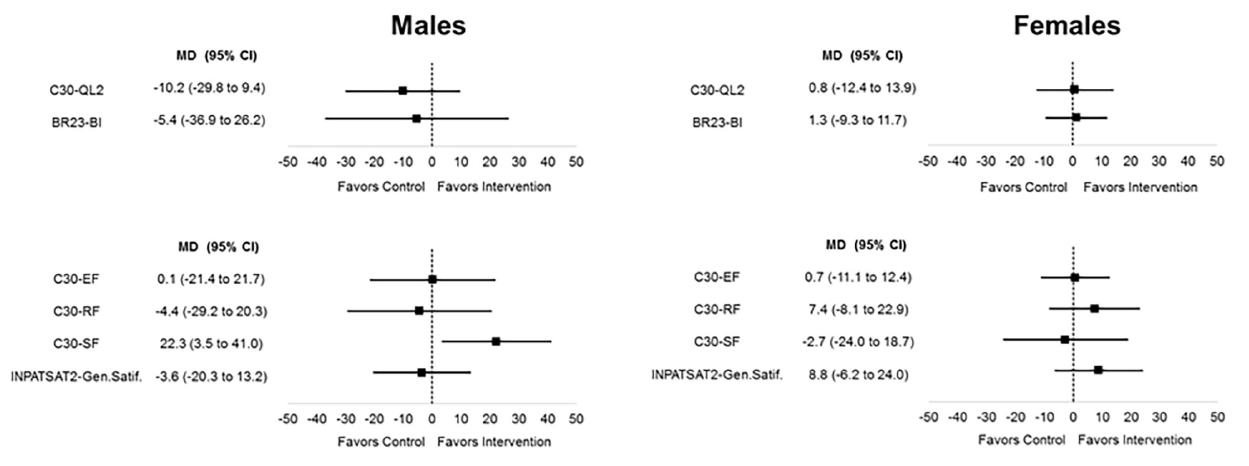
FIGURE 3 | Primary and secondary outcome measures stratified by sex: variation from baseline (hospital admission) to postoperative (15 days after surgery).